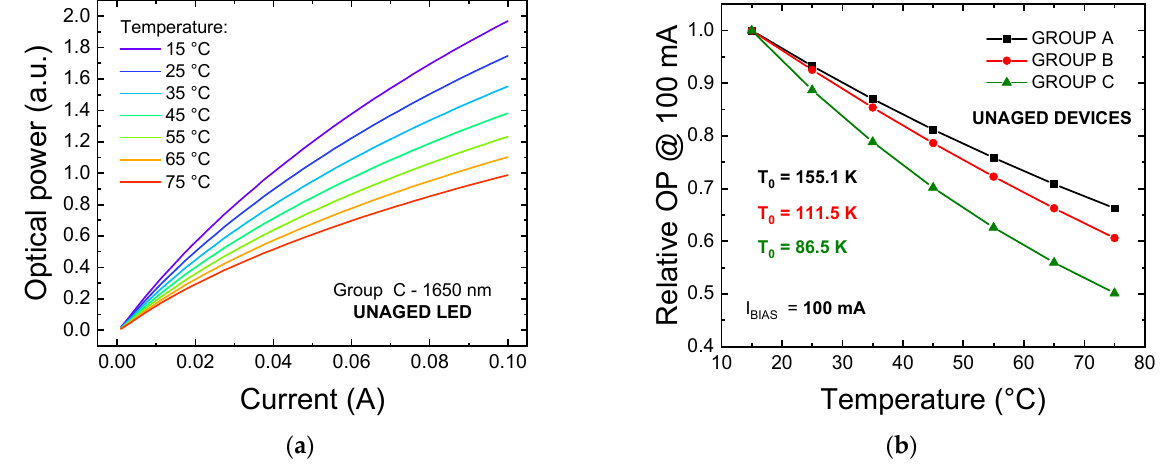
Figure 4. ( a ) L–I–T curves measured on an unaged group C sample; ( b ) normalized thermal drop of the optical power, measured at 100 mA, for one representative samples of each of the three groups of LEDs under investigation.